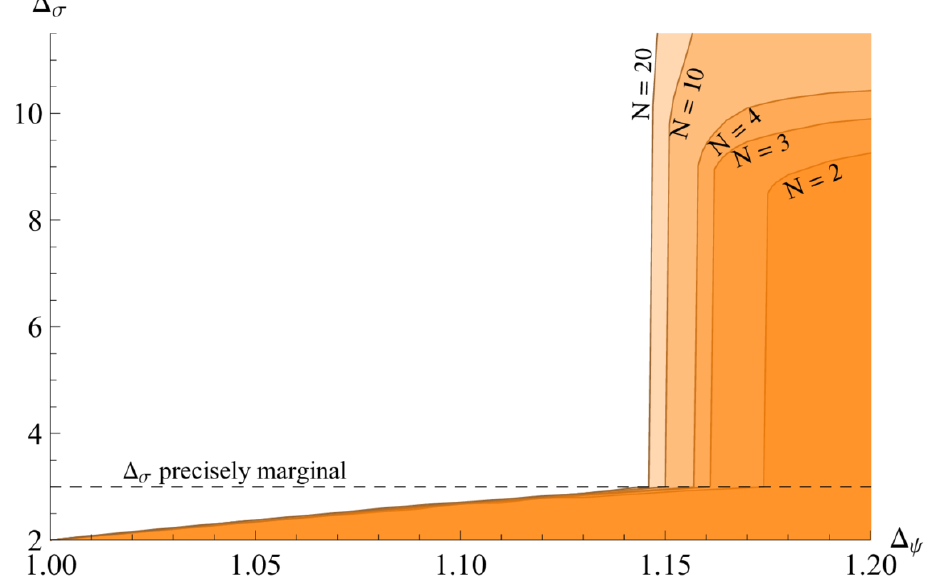
Figure 3 . Upper bounds on the scaling dimension of the lowest-lying parity-odd O ( N ) singlet, (cid:1) (cid:27) , for a unitary CFT containing fermions with dimension (cid:1) . Above, we focus on the cases N = 2 ; 3 ; 4 ; 10 and 20. As (cid:1) ! 1, the bound approaches the free theory value of (cid:1) (cid:27) =